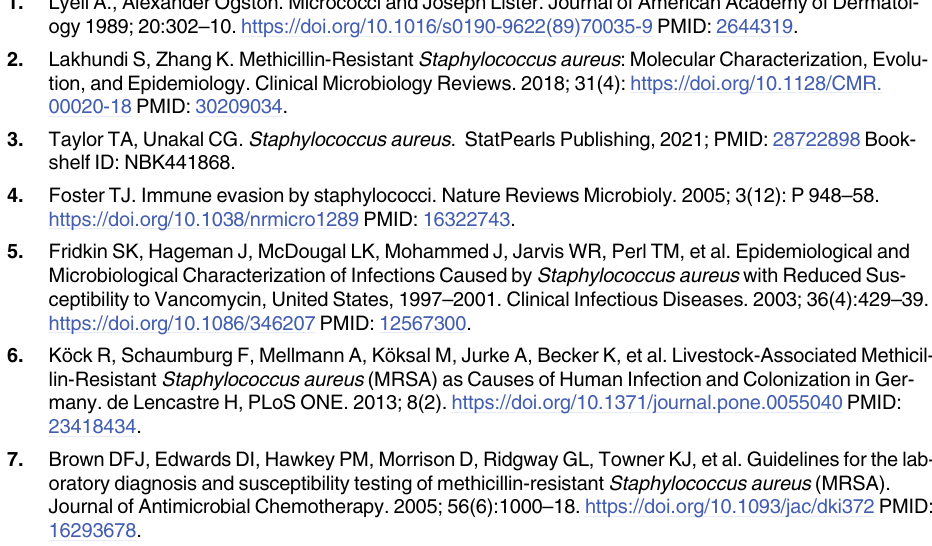
S2 Table. Metadata for bacterial isolates from patients with MRSA